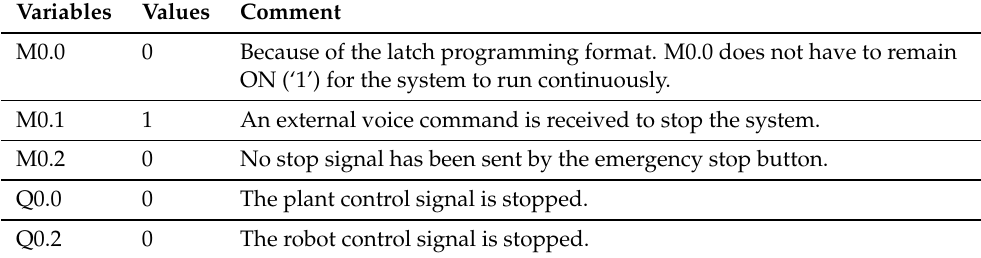
Table 2. PLC healthy running system start-stop interlock variables values